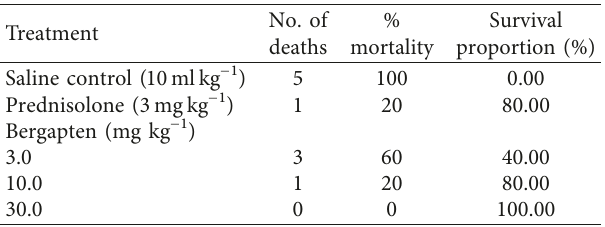
C57BL/6 mice were sensitized by single administration each of 500 µ l BSA (0.5mgml − 1 ) and 500 µ l triple antigen containing 2 × 10 7 of Bordetella pertussis cells. Mice were treated daily for 10days with either saline 10mlkg − 1 , prednisolone 10mgkg − 1 , or bergapten 3–30mgkg − 1